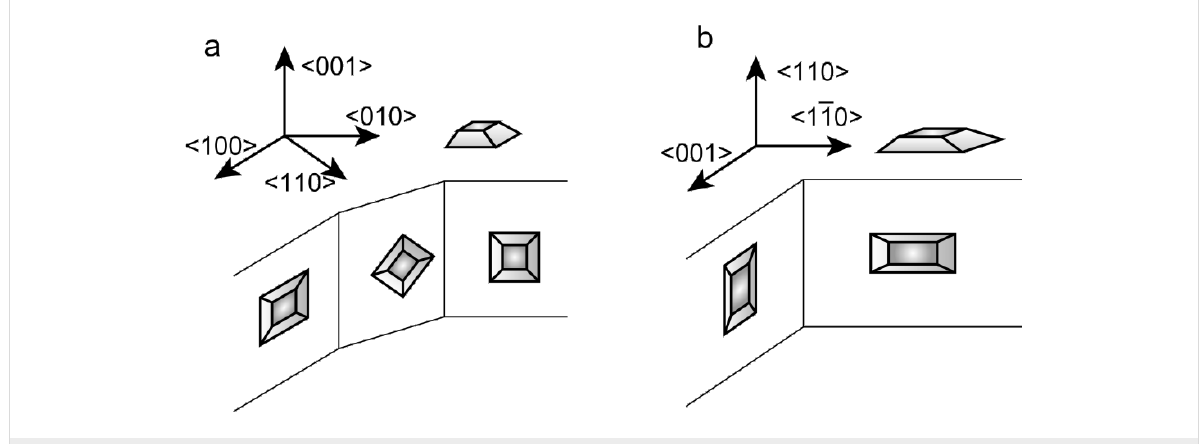
Figure 4: Schematic illustrations of profile-view imaging. a) Nanoparticles on STO{100} planes can be viewed from two directions that make a 45° angle, and b) those on STO{110} can be viewed from two directions that make a right angle.